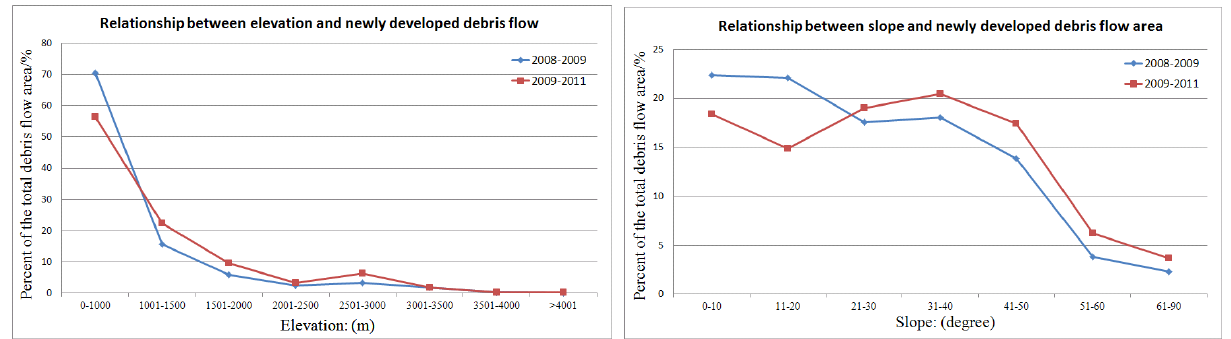
Figure 10. Relationship between newly developed debris flow area and topographic